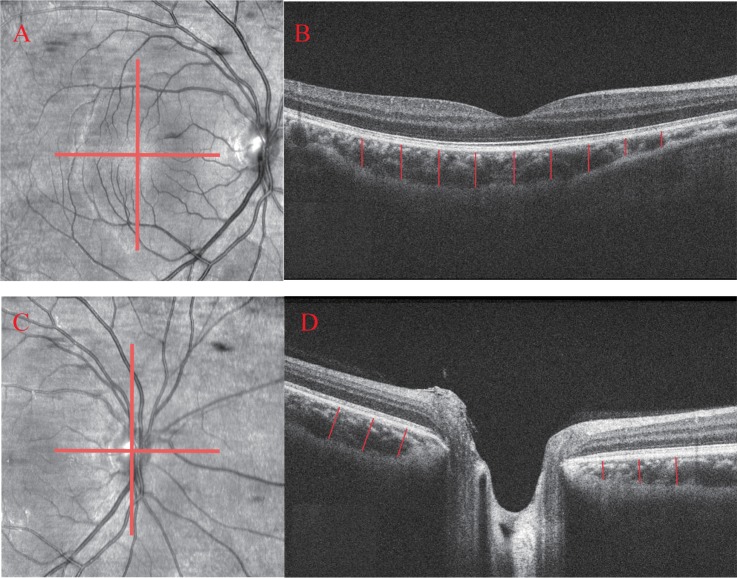
Measurement illustrations of choroidal thickness at different locations.(A) and (C) Images of the position of scan lines passing through the central part of the fovea and the disc. (B) and (D) Images of choroidal thickness from line scans showing the locations of the choroidal thickness measurements. Each red line is 500 μm apart from each other.